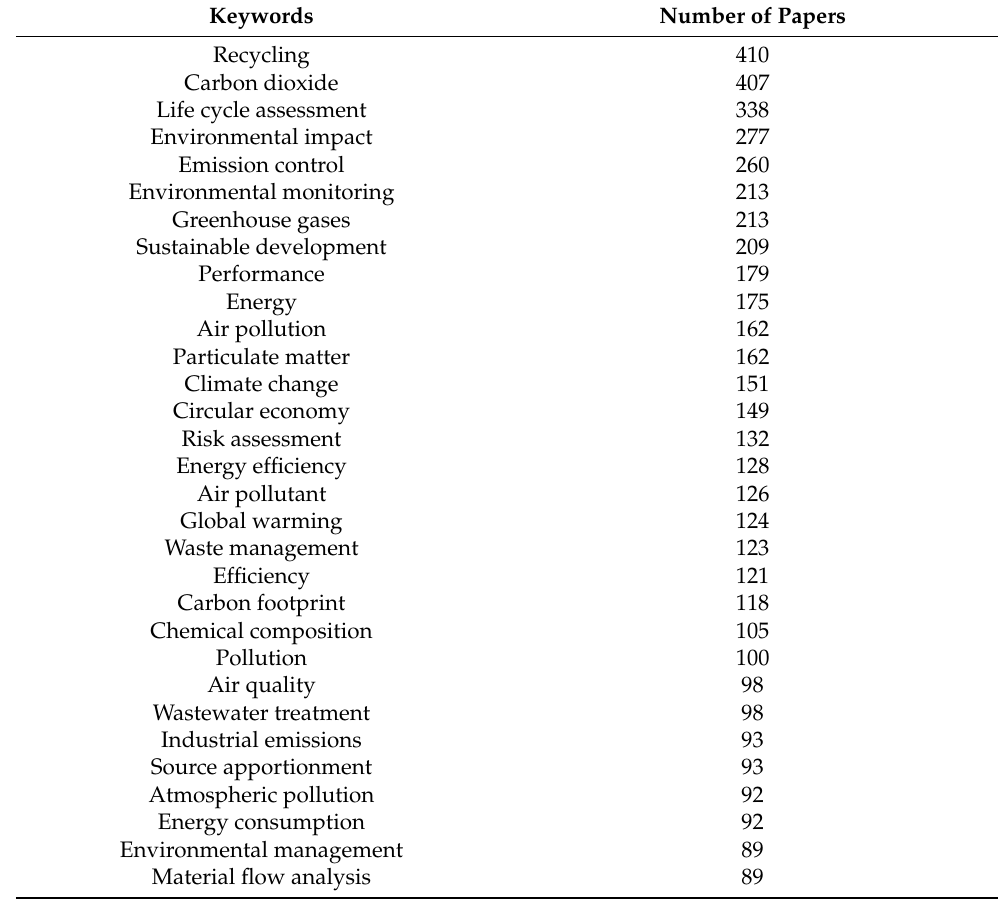
Table 6 indicates the ranking of keywords according to the number of documents (i.e., papers) in which each keyword is cited. Table 6. Ranking of keywords used in the analyzed articles. Reported results derived from the analysis of articles identified during the first round of bibliographical research. The results refer to selected works published between 2019 and